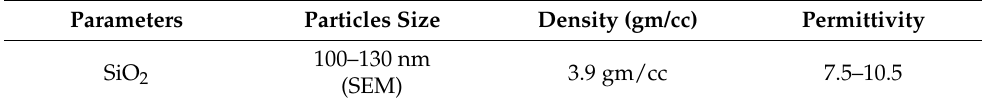
Table 3. Specification of